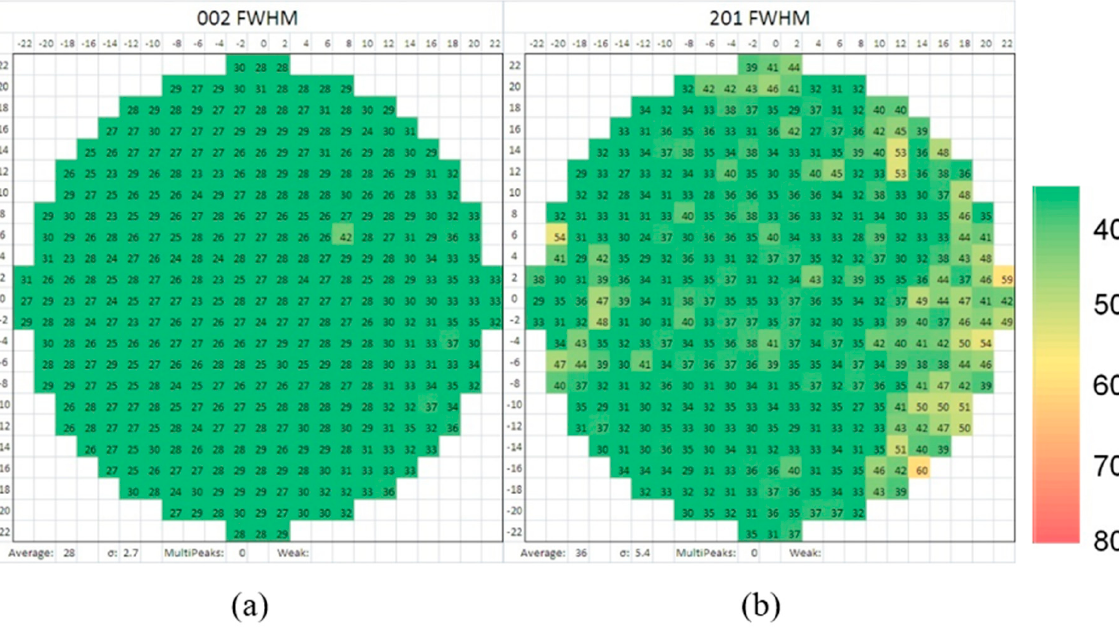
Figure 4. Relationship between the optical absorption coefficient at 450 nm and the residual oxygen concentration in the crystal.